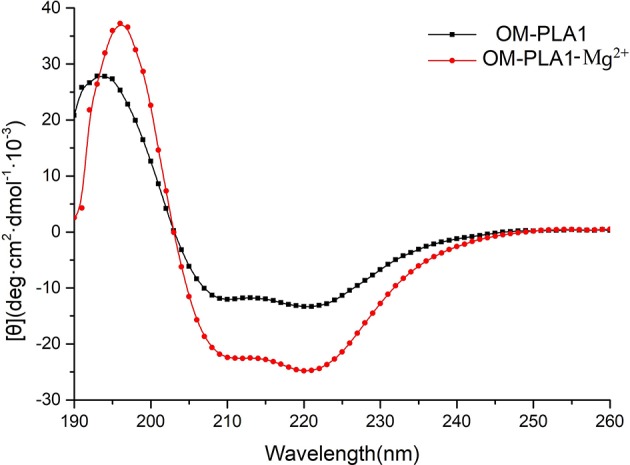
[θ] values of OM-PLA1 and OM-PLA1-Mg2+ under different wavelengths by circular dichroism spectroscopy.